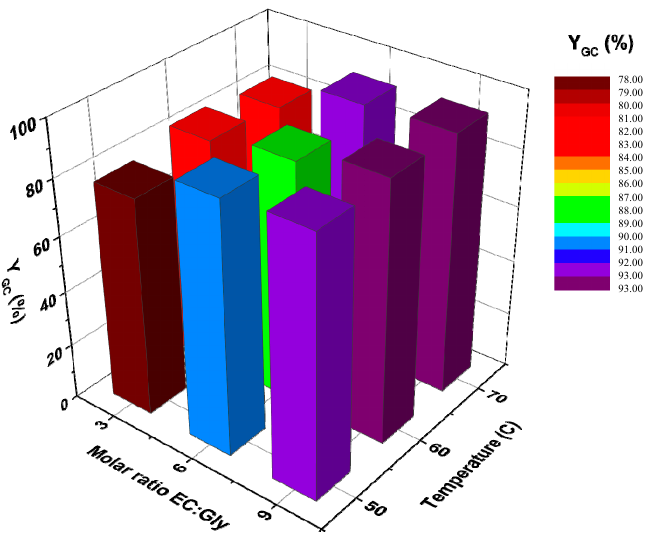
Figure 9. Effect of the molar ratio of EC to Gly and temperature on the yield to GC. Conditions: enzyme load: 3% w / w ; solvent: tert-butanol (30% v / v ); t = 100 h; agitation speed: 400 rpm.